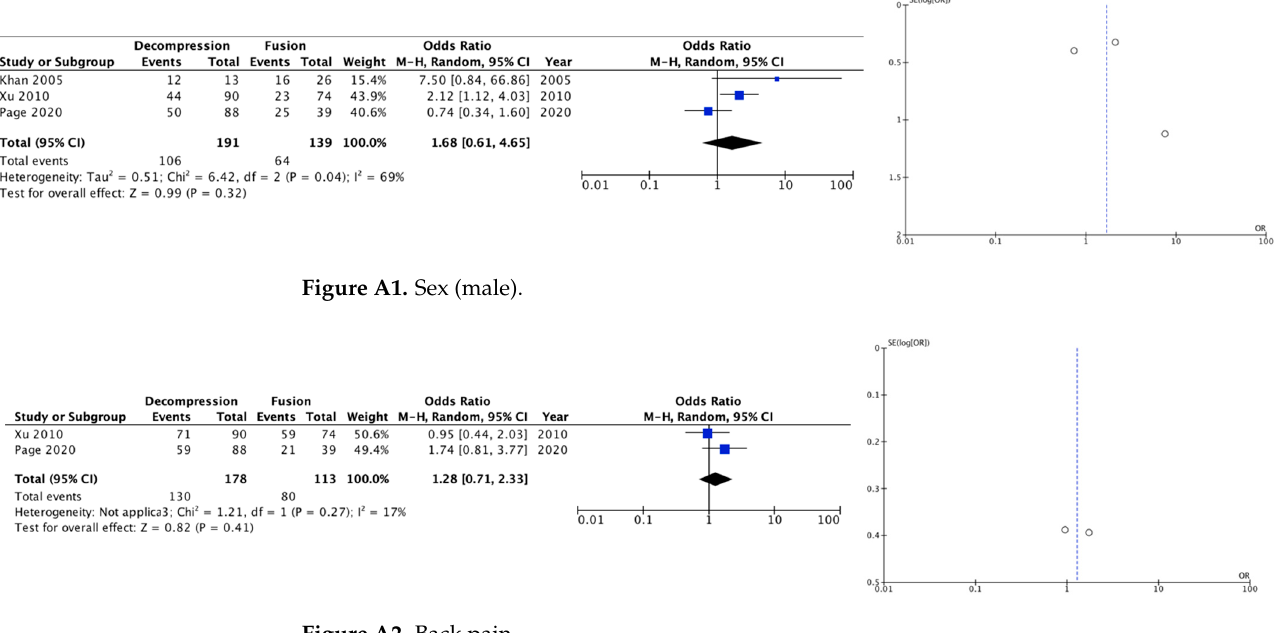
Figure A2. Back pain.